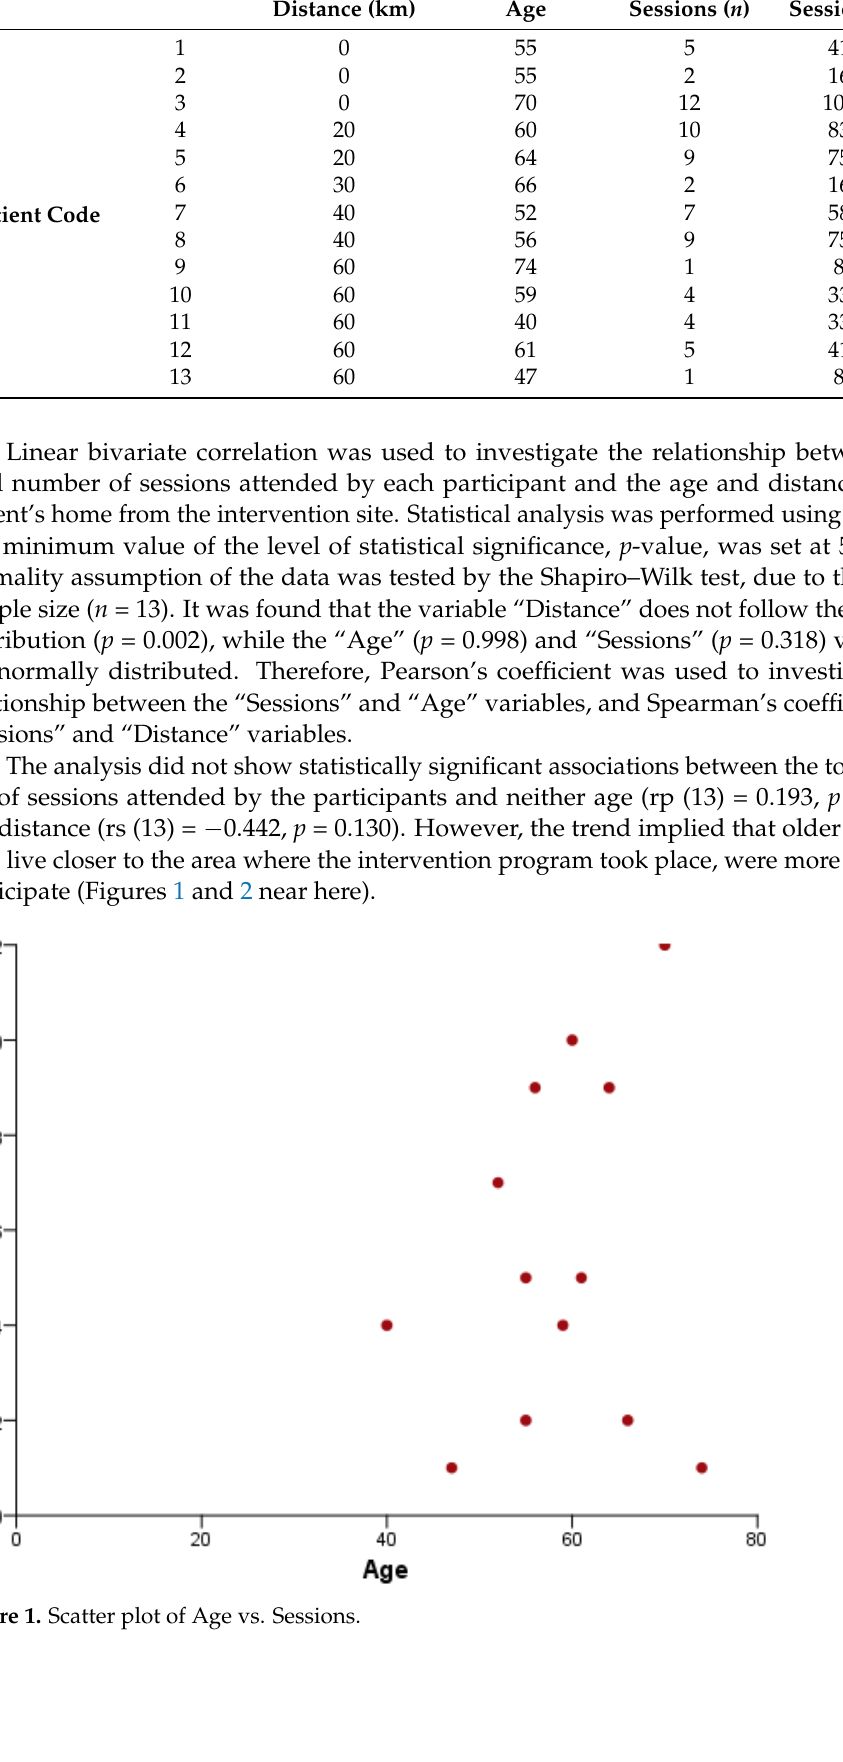
Figure 2. Scatter plot of Distance vs. Sessions. 10. Discussion Our clinical impression at baseline was that emotional distress was strongly present, yet this was not revealed in our psychometric screening. However, as has previously been suggested, psychopathology may often be unrecognized or may not emerge until after treatment has ended [18]. While the initial intention was to use the Symptoms’ Checklist-90 (SCL-90) quantita- tively, it was finally used descriptively and qualitatively, due to the small number of par- ticipants that completed the study. This actually limits the mixed method approach of the study and stresses the qualitative aspects of it. However, as stated by Goodill [34], and